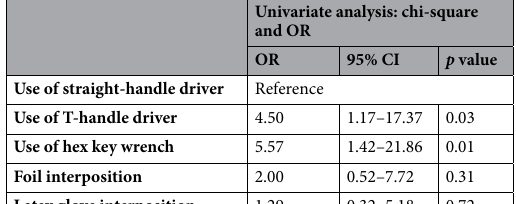
Univariate analysis: chi-square and OR